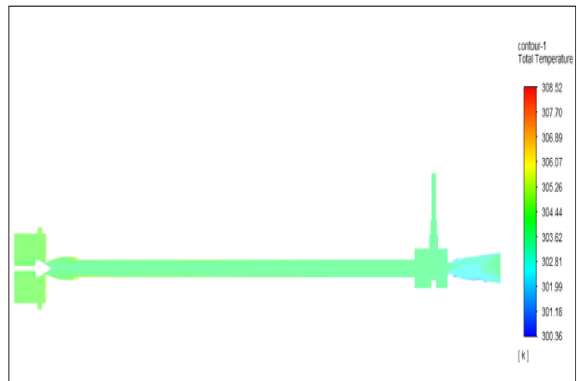
Figure 32. Nylon at 8 bar.